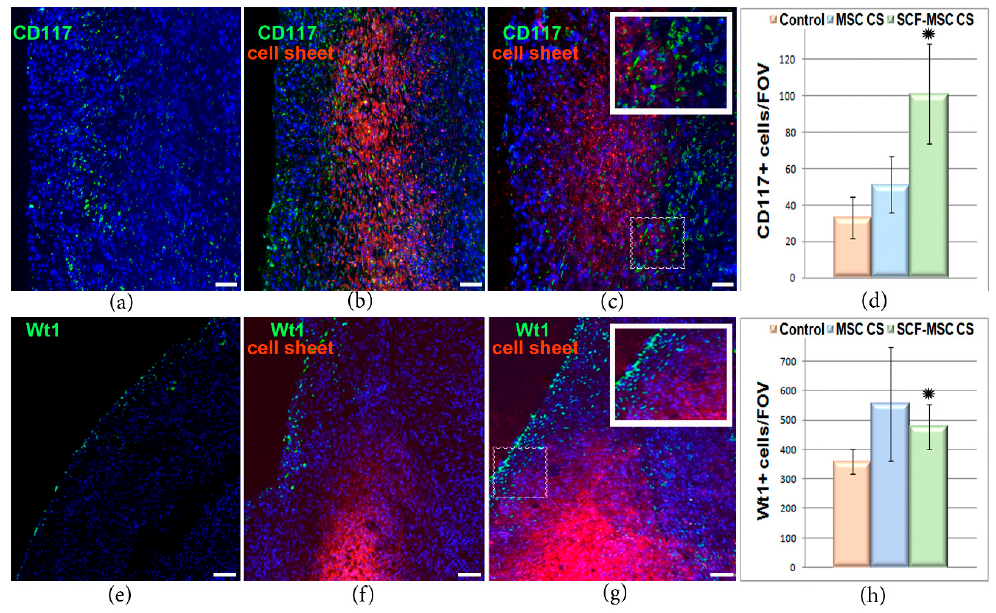
Figure 5. Histological analysis of the ischemic myocardium at day 5 after MI induction and CSs transplantation. ( a – c ) Representative images of myocardium sections stained for Wt1+ cells (green) from the sham-operated group ( a ), MSC CS ( b ) and SCF-MSC CS ( c ) group. PKH26-labeled MSCs comprising the cell sheet are in red. Nuclei are stained with DAPI. Scale bar-100 µm. The small square bar indicate the area of the section where the magnified view (large square bar) was taken from; ( d ) Wt+ cells count in the epicardial area of the section; data are presented as mean ± SD (Mann–Whitney U-test), * -SCF-MSC CS vs. control group, p = 0.033. ( e – g ) Representative images of myocardium sections stained for c-kit+ cells (green) from the sham-operated group ( e ), MSC CS ( f ) and SCF-MSC CS ( g ) group. PKH26-labeled MSCs comprising the cell sheet are in red. Nuclei are stained with DAPI. Scale bar-100 µm. The small square bar indicate the area of the section where the magnified view (large square bar) was taken from; ( h ) c-kit+ (CD117+) cells count; data are presented as mean ± SD (Mann–Whitney U-test), * -SCF-MSC CS vs. control group, p = 0.0495.